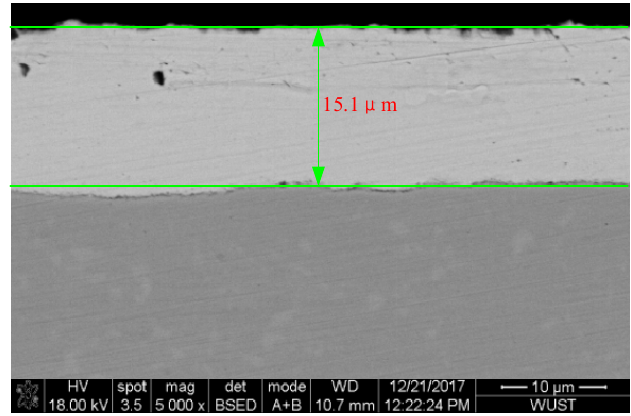
Figure 1. Cross-section microstructure of galvanized steel sheet DP600.